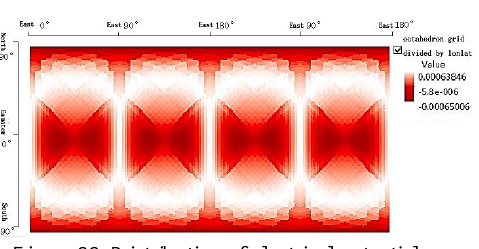
Figure 22. Distribution of electrical potential energy of spherical diamond discrete grids octahedron grid divided by lonlat